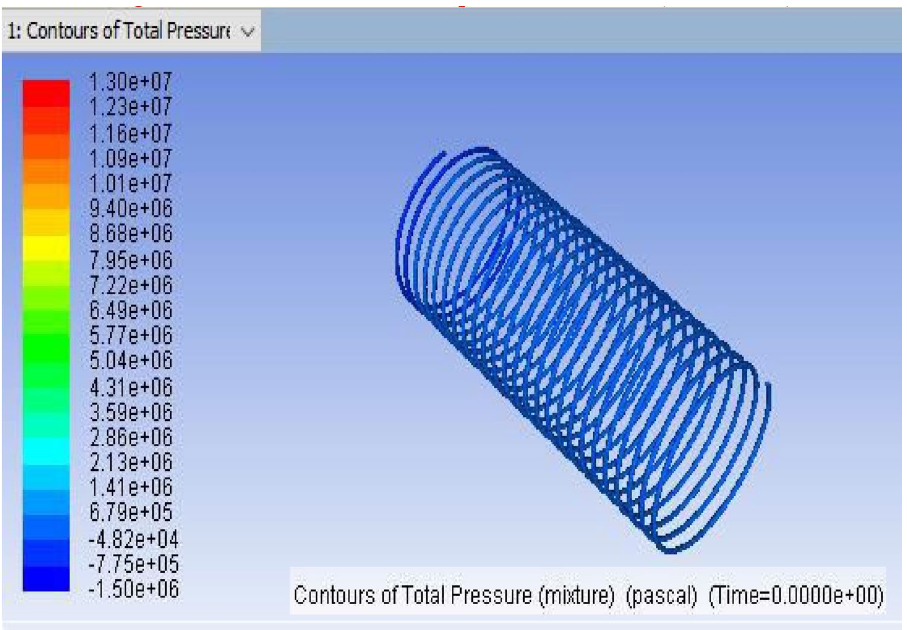
Figure 9. CFD result for a total pressure of Coil-3 (3962.4